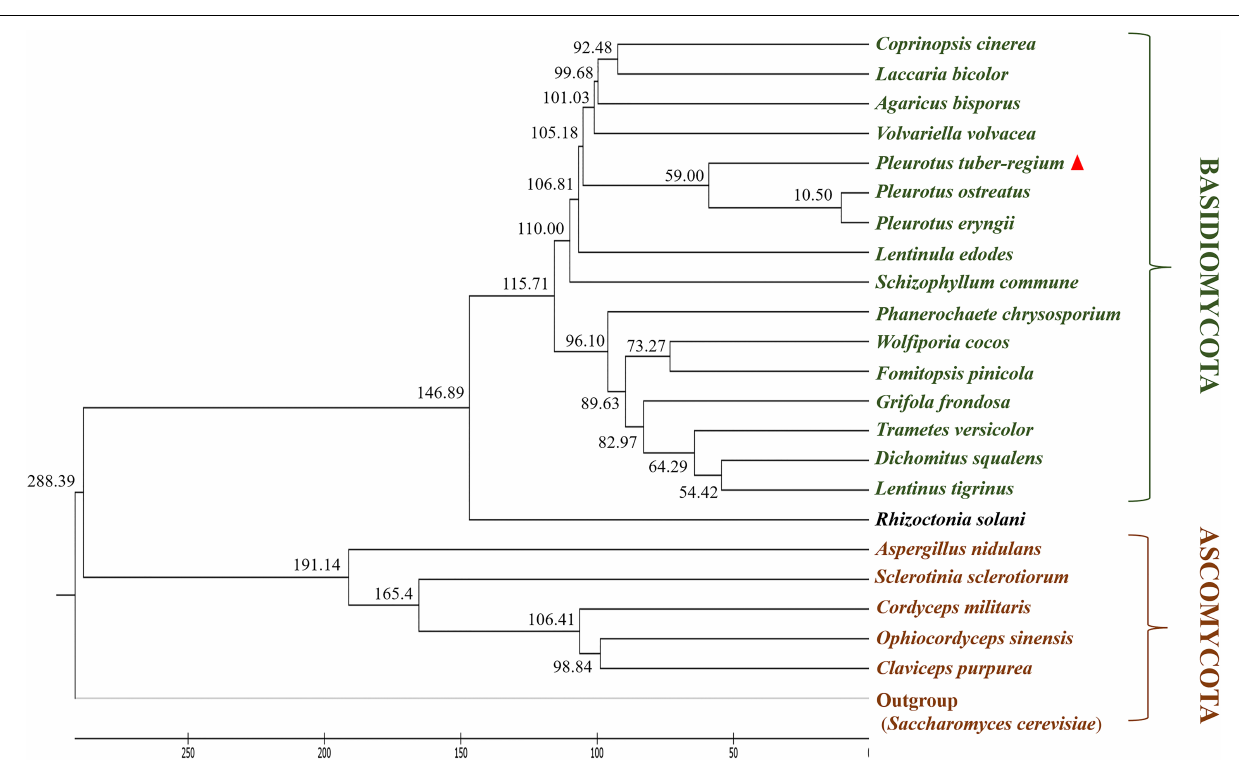
mycelia in W. cocos (Zhang et al., 2016). The